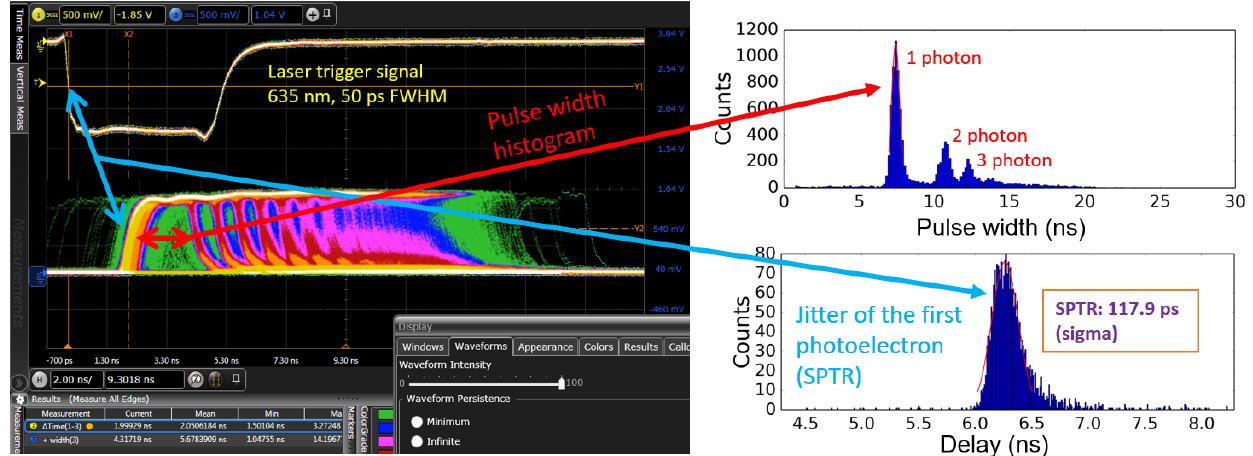
Figure 12. ( left ) MUSIC discriminated output with PZ cancellation and optimal threshold using the Hamamatsu SiPM S13360 − 3075CS at 5 V of over − voltage. ( Top-right ) Pulse width histogram of the discriminated. ( Bottom-right ) Delay distribution of the first photoelectron.